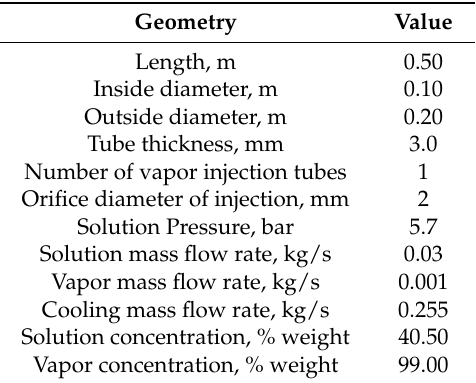
Table 2. Geometric and input data of double pipe heat exchanger.